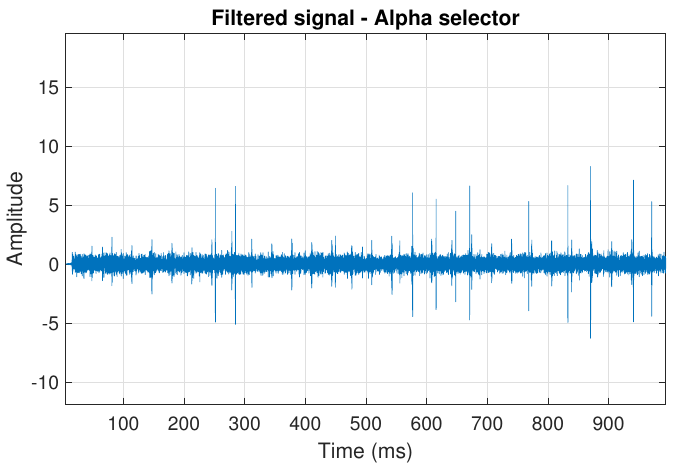
Figure 14. Filtered signal s 2 by Alpha selector.